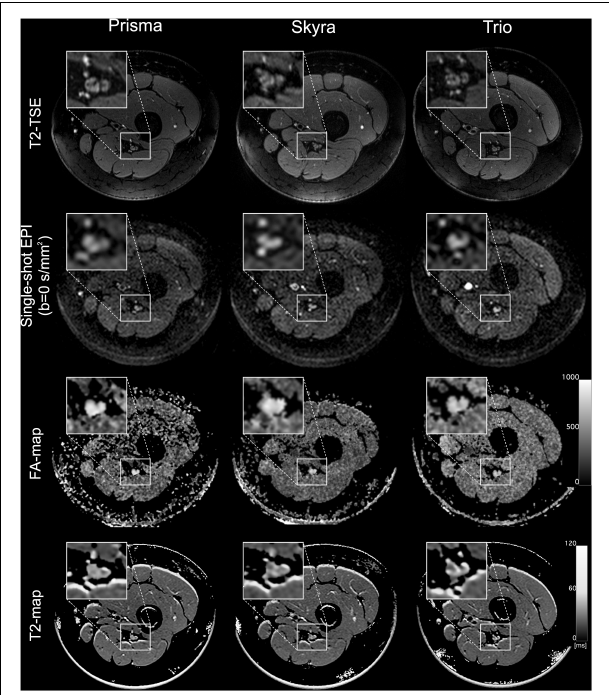
FIGURE 2 | MR imaging of the left leg at mid-thigh level acquired in the same individual on three different MR scanners (Prisma, Skyra, and Trio). From top to bottom, the rows show representative images for a T2 turbo spin echo (TSE) sequence, a single-shot echo planar imaging sequence (b0-image), a calculated FA-map and an exemplary T2-map generated by the OsiriX plugin T2 map. Insets show a magnification of the sciatic nerve.